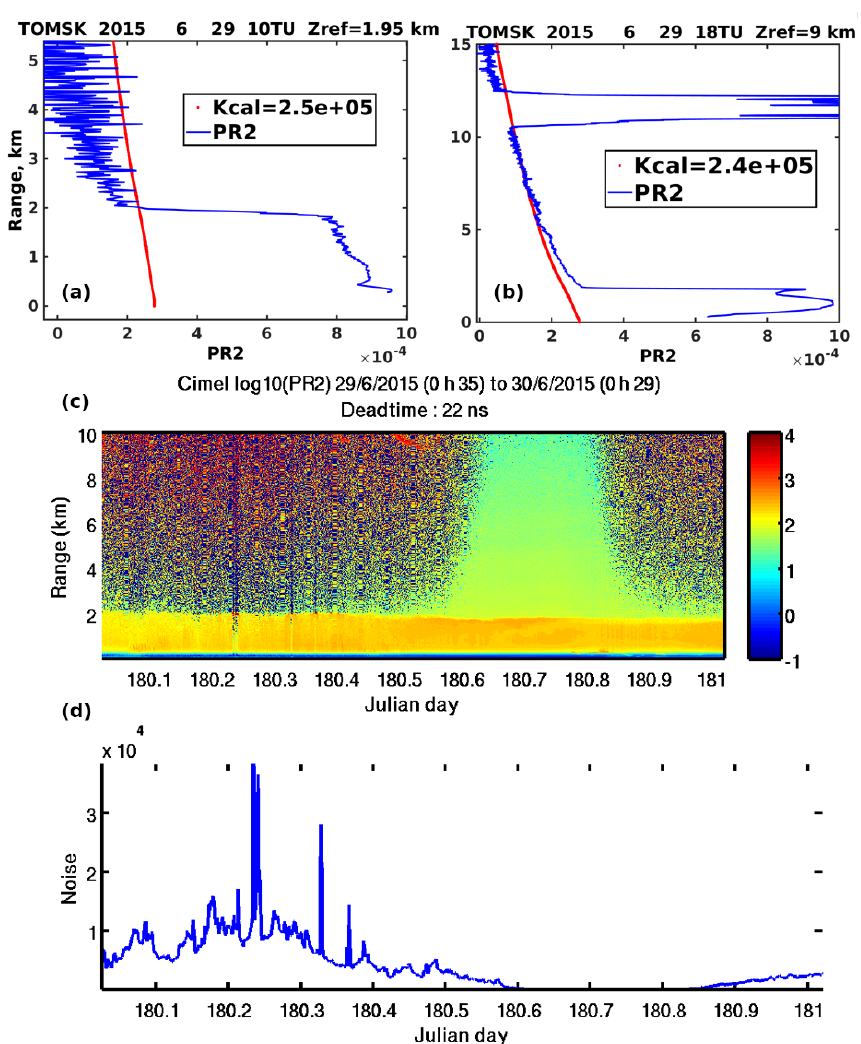
Figure 1. Vertical profiles of the attenuated backscatter signal (PR2) for daytime (a) and night-time (b) averaged over 30min on 29 June 2015 using a calibration constant K to normalize the night-time PR2 to attenuated molecular backscatter at 10km below the cirrus layer. The red curve is the attenuated molecular backscatter signal. Daily evolution of the vertical profiles of the log10 of the attenuated backscatter (c) and the background signal due to solar radiation (d)